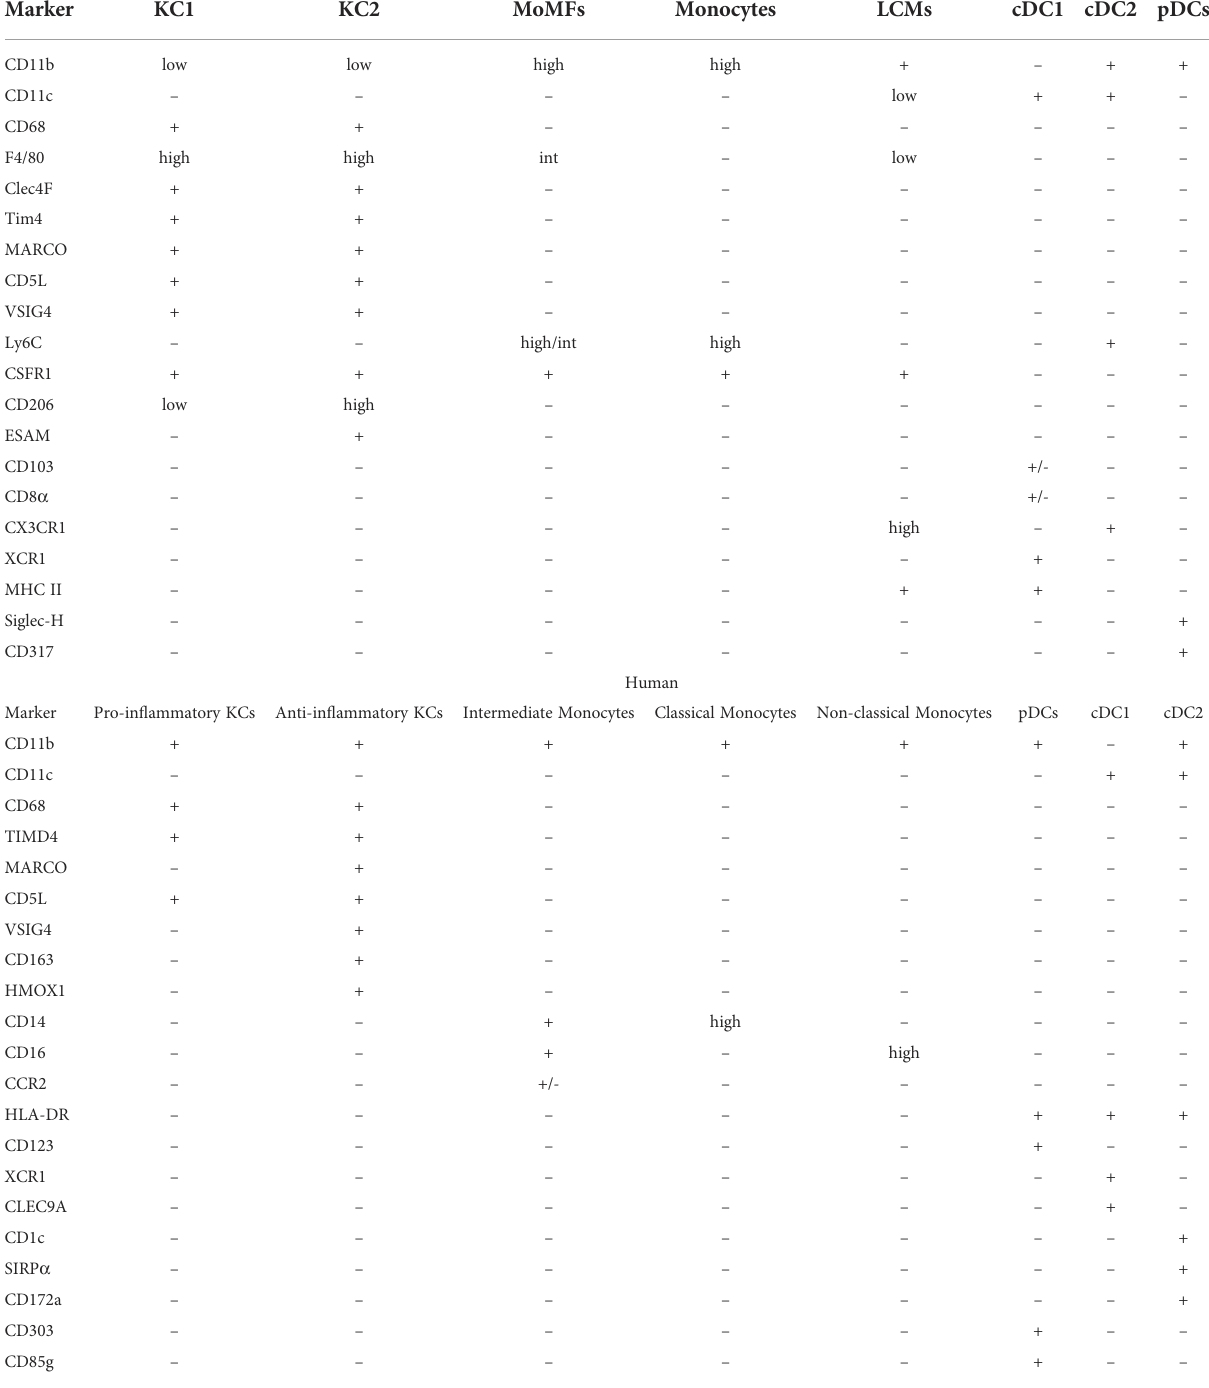
TABLE 2 Basic markers of hepatic mononuclear phagocytes in mice and humans (55, 66 –